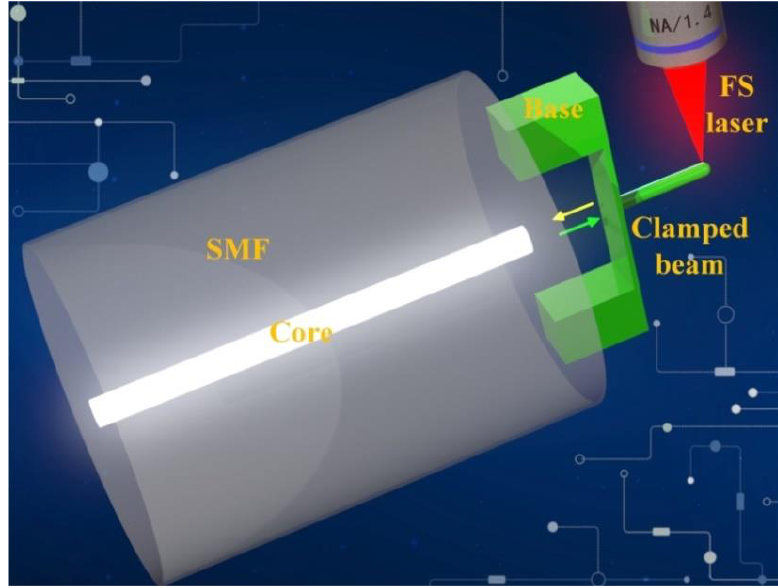
Figure 1. Schematic diagram of fiber-tip microforce sensor (FTMS).